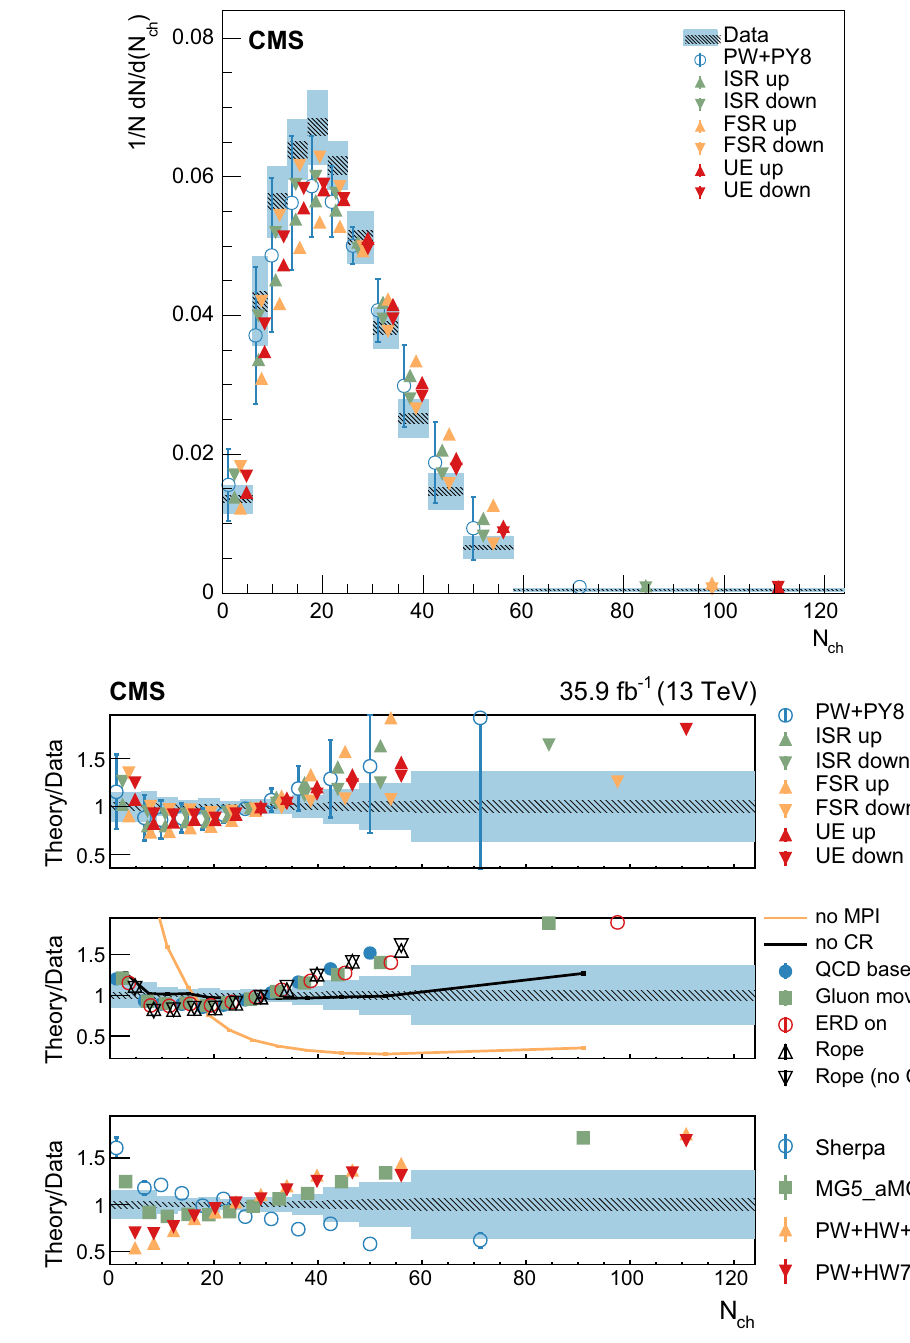
Fig. 4 The normalized differential cross section as a function of N ch is shown on the upper panel. The data (colored boxes) are compared to the nominal Pw+Py8 predictions and to the expectations obtained ( M ) or from varied α ISR Z S α FSR ( M ) Pw+Py8 setups Z S (markers). The different panels on the lower display show the ratio between each model tested (see text) and the data. In both cases the shaded (hatched) band represents the total (statistical) uncertainty of the data, while the error bars represent either the total uncertainty of the Pw+Py8 setup, computed as described in the text, or the statistical uncertainty of the other MC simulation